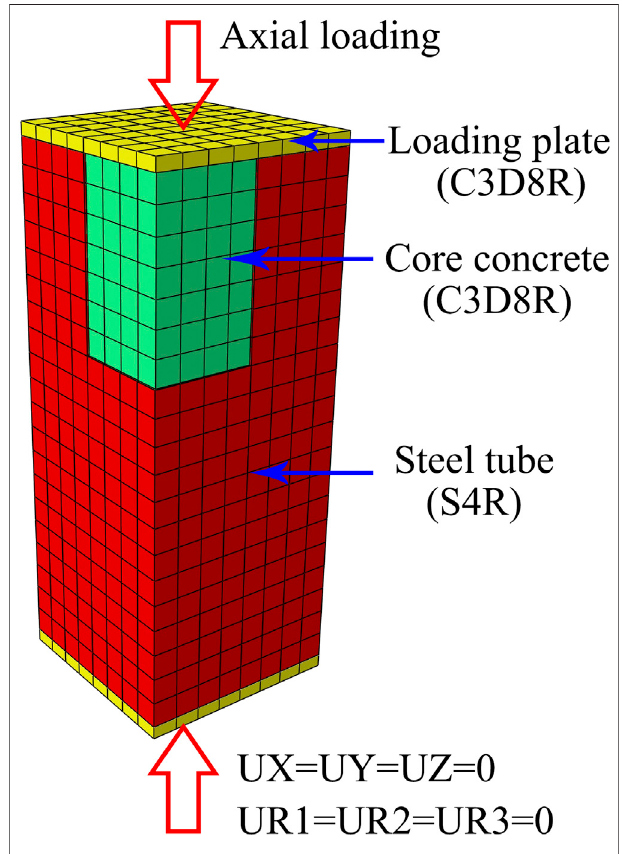
FIGURE 4 | Mesh generation of FE models.